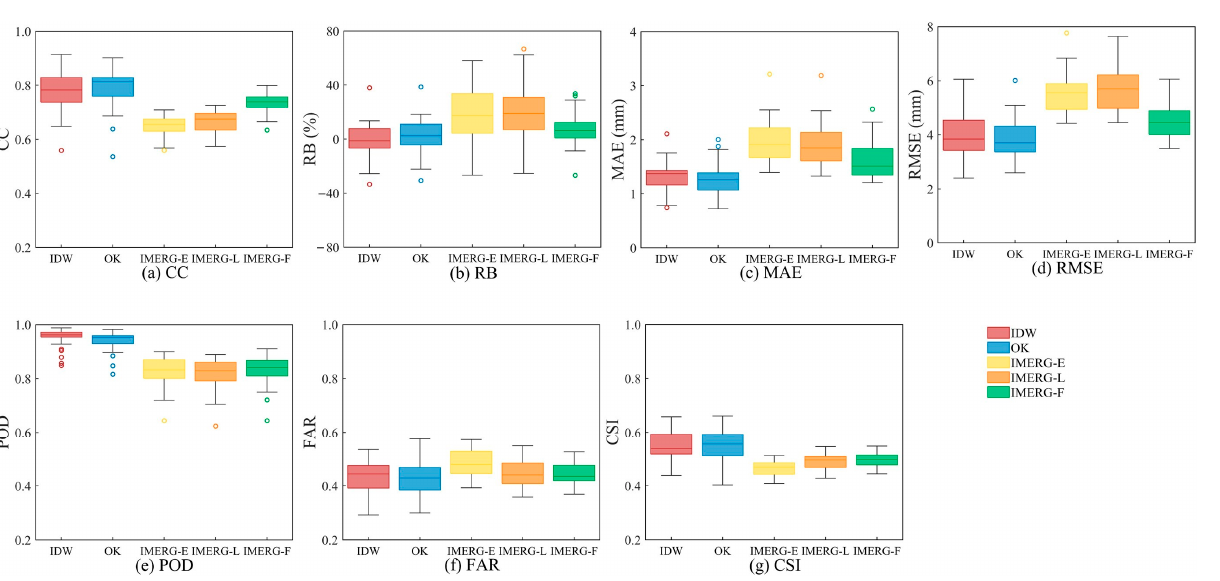
Figure 3. Box plot of the statistical metrics of daily precipitation estimated from two interpolation methods and three IMERG SPPs at the 43 weather stations in MRYRB (1 January 2008–31 December 2019).